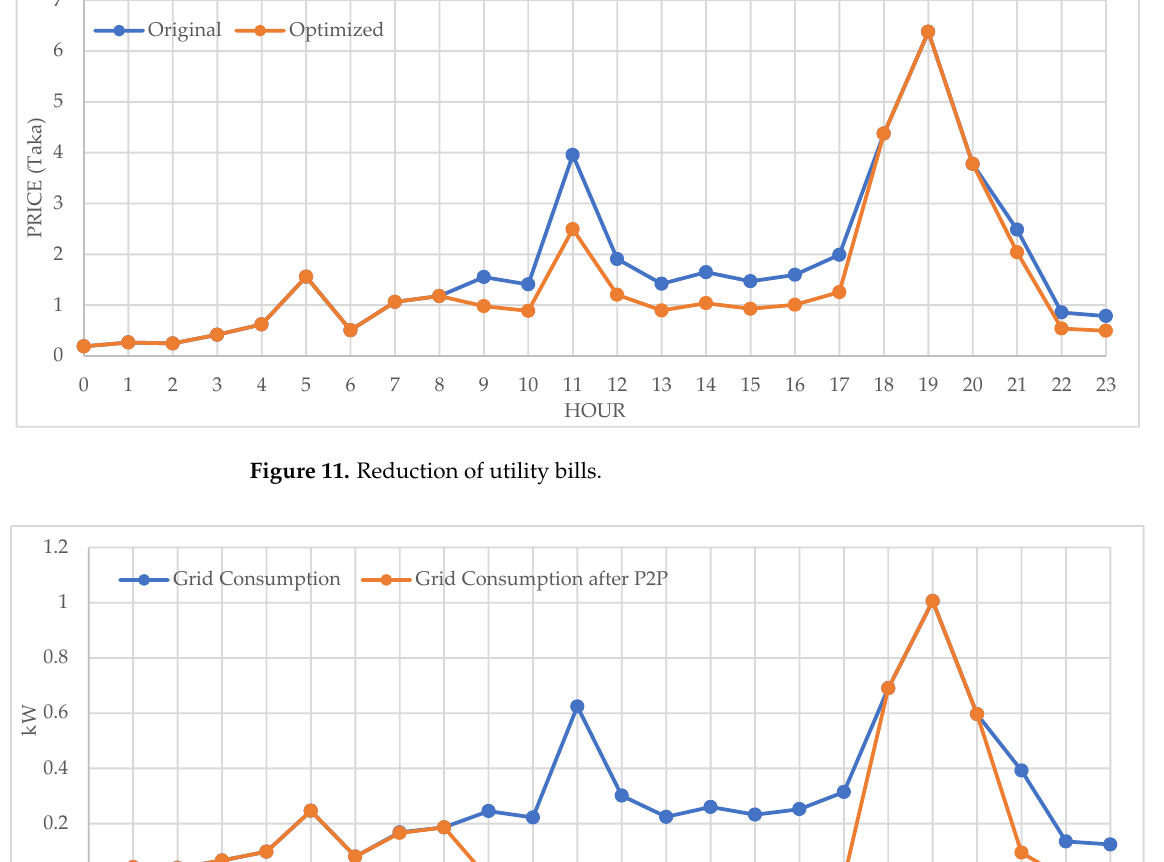
Figure 10. Hourly internal selling price of the prosumer .